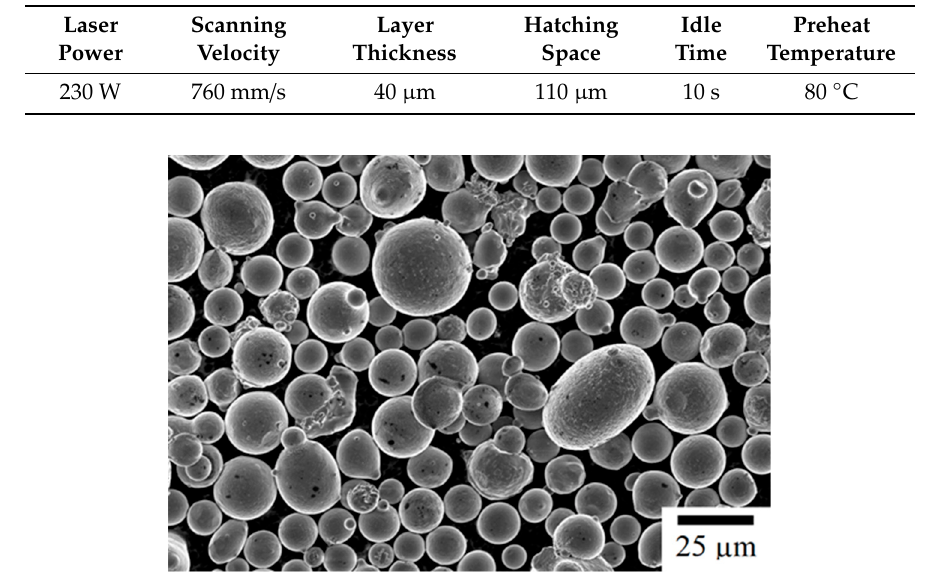
Table 1. Process parameters used for selective laser melting (SLM).